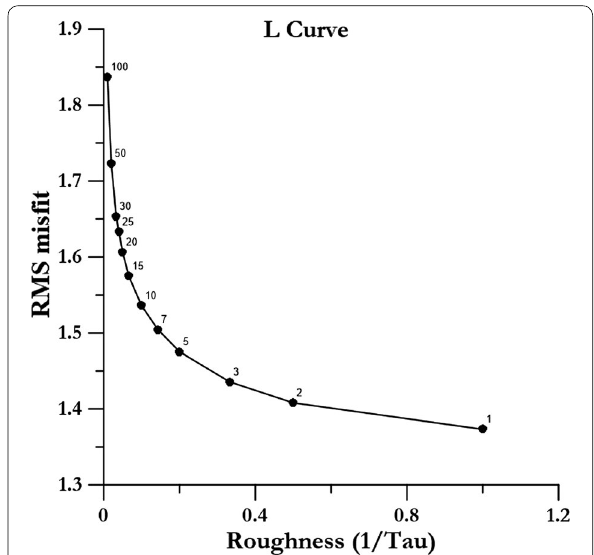
Fig. 6 Roughness against model fit tradeoff curve ( L -curve) obtained for different smoothness regularization parameters ( τ ) versus RMS values for 2-D inversion